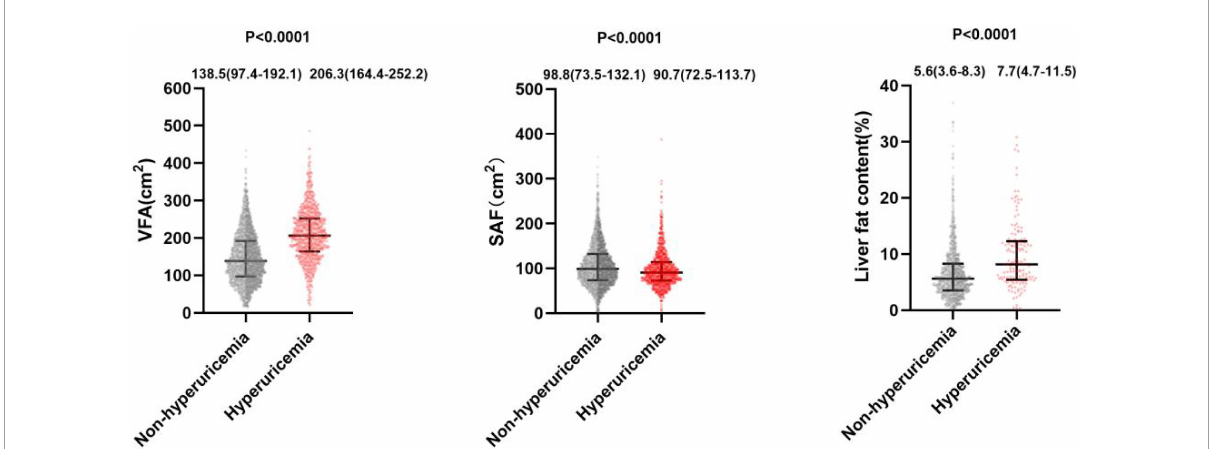
FIGURE1 Relationship between hyperuricemia and VFA, SAF, or LFC. VFA and LFC are significantly higher in patients with HUA than in those without (VFA: 206.3 [164.4–252.2]cm 2 , n = 2,749 vs. 138.5 [97.4–192.1]cm 2 , n = 948, P < 0.0001; LFC: 7.7 [4.7–11.5]%, n = 2,749 vs. 5.6 [3.6–8.3]%, n = 948, P < 0.0001), whereas SFA is significantly lower in patients with HUA than in those without (90.7 [72.5–113.7]cm 2 , n = 2,749 vs. 98.8 [73.5–132.1]cm 2 , n = 948, P < 0.0001).